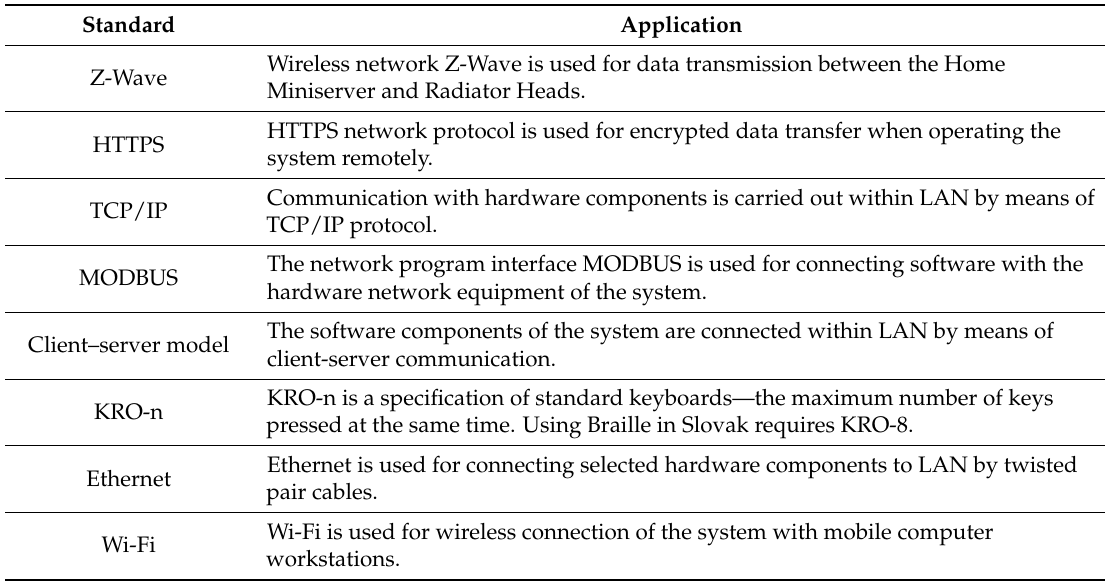
Table 2. Overview of standards used by RUDO system. Source: